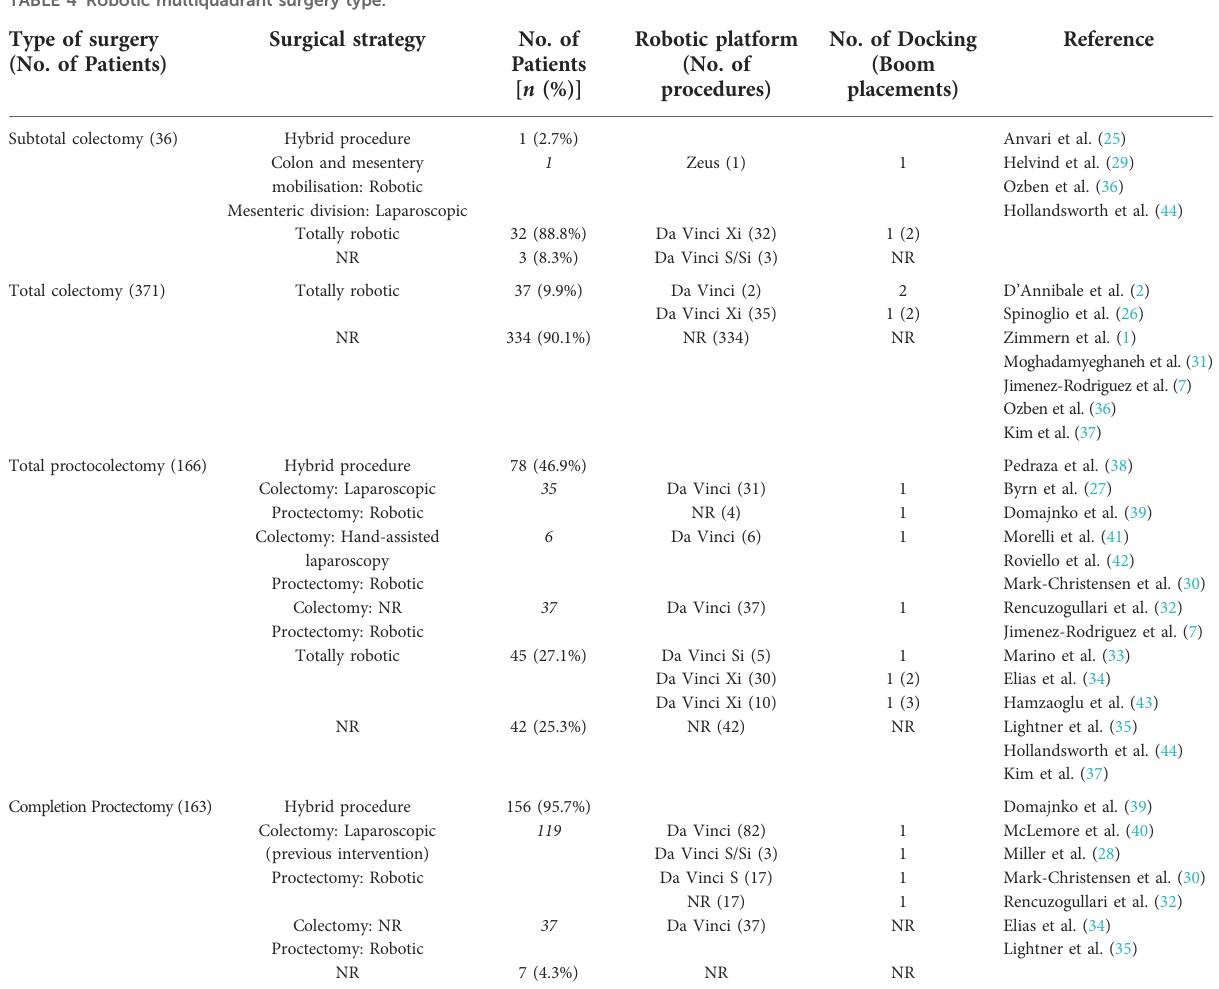
TABLE 4 Robotic multiquadrant surgery